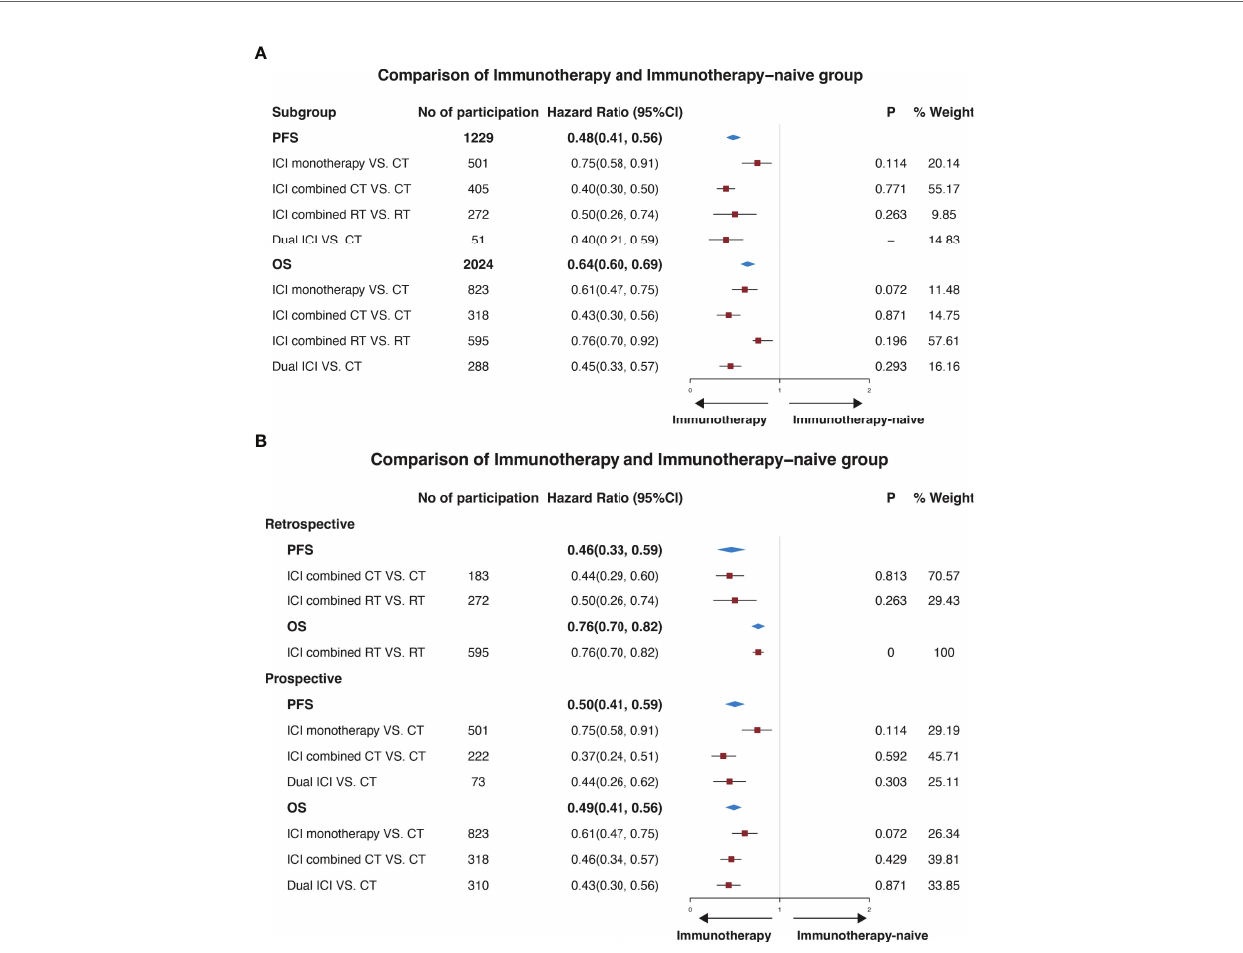
FIGURE 2 | Forest plots illustrating pooled results of ef fi cacy for the comparison of patients with or without immune checkpoint inhibitors. The immunotherapy group was de fi ned as patients who received ICI. The immunotherapy-naive group was de fi ned as patients who didn ’ t receive ICI. (A) illustrates a pooled result in all studies, and (B) illustrates a pooled result of subgroup analysis according to the type of study. No, number; CI, con fi dence interval; P, p-value of heterogeneity. PFS, progression-free survival. OS, overall survival; CT, chemotherapy; RT,